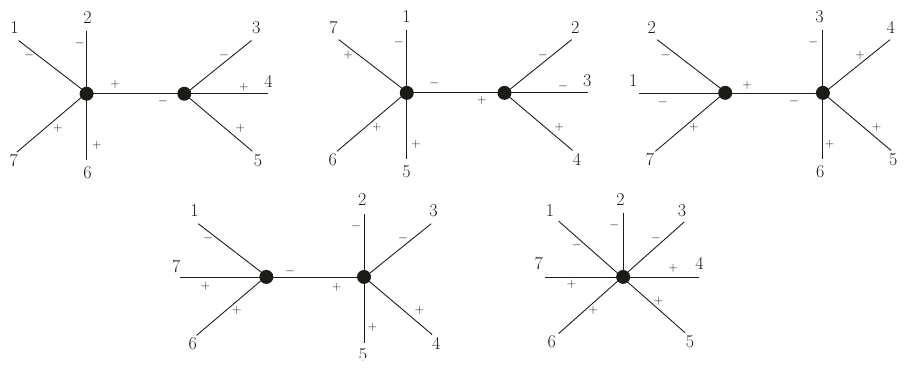
Figure 5 . Diagrams contributing to the 7-point NMHV amplitude ( − − − + + + +)